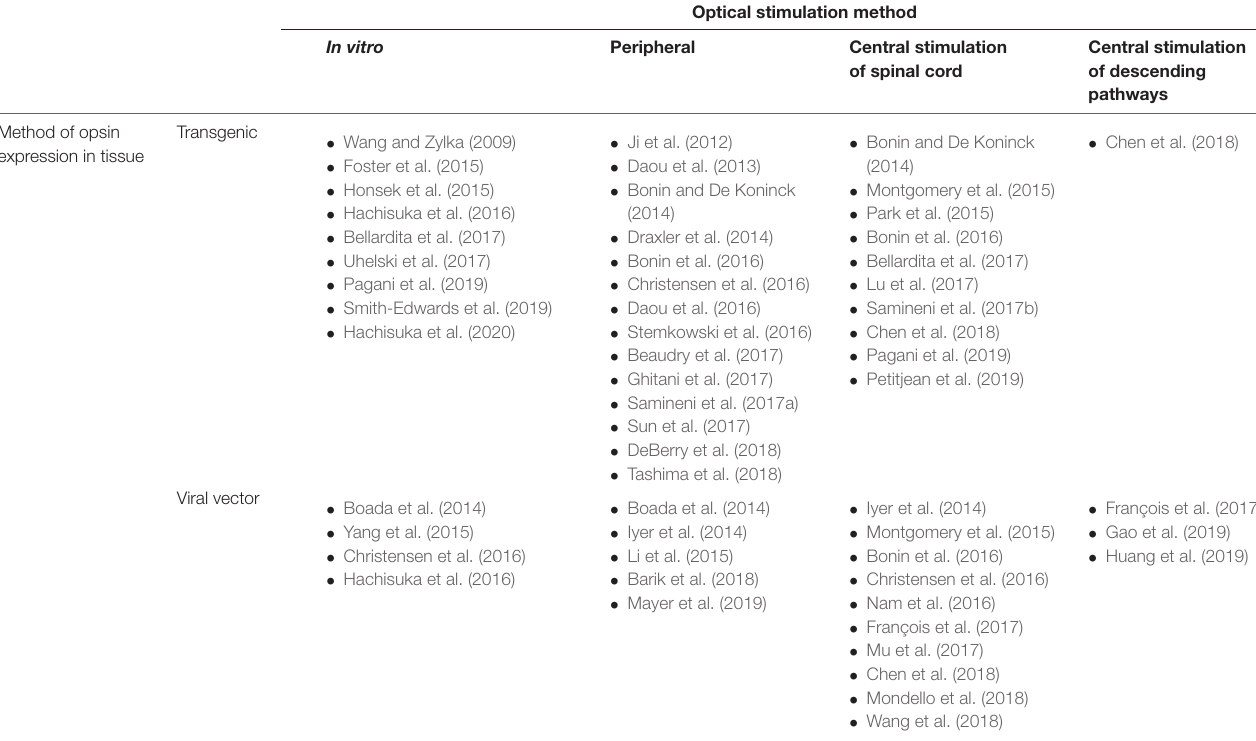
TABLE 1 | Summary of all publications utilizing optogenetics for interrogation of spinal cord somatosensory circuitry.